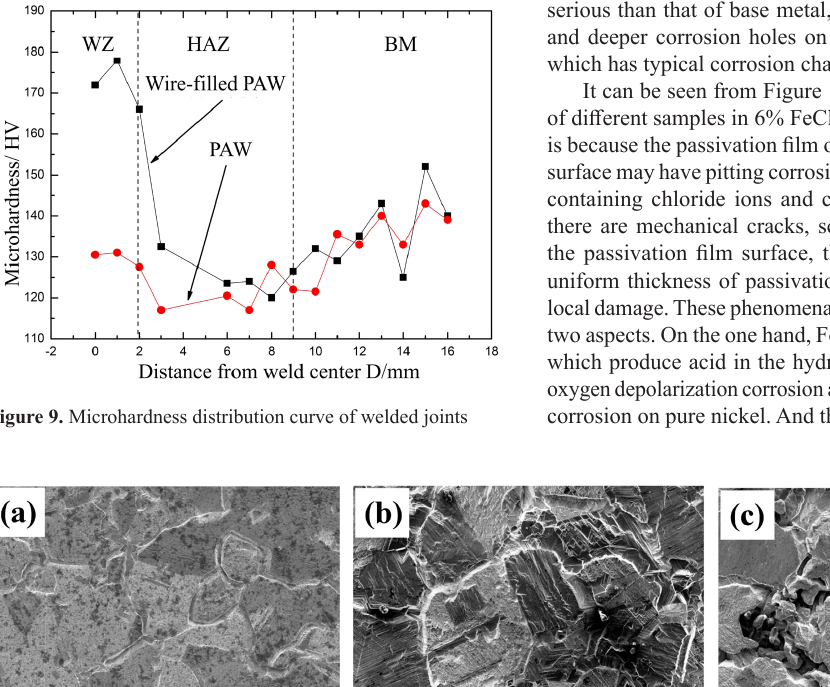
Figure 10. SEM morphology of samples corroded in 6% FeCl